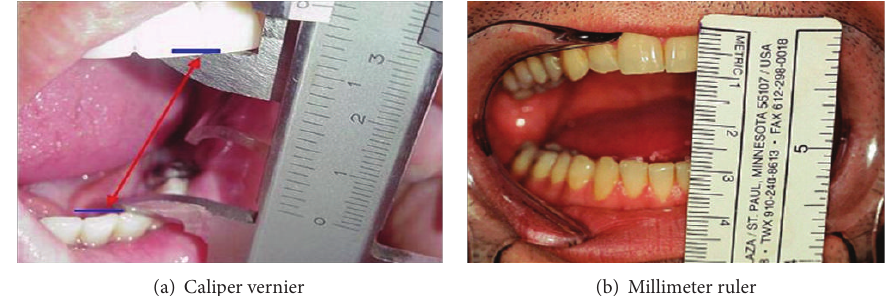
Figure 2: Trismus measurement with different tools.